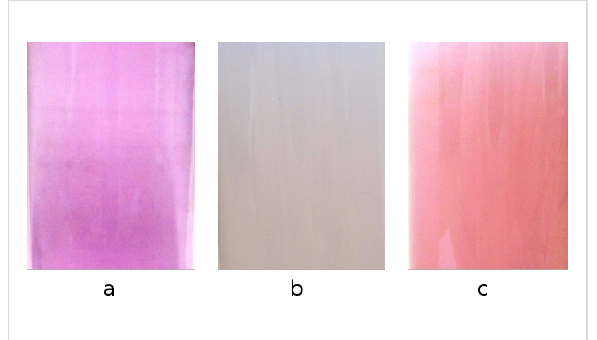
Figure 5: The color during the complexation with phenolphthalein and adamantyl carboxylate. (a) Phenolphthalein solution in water at pH > 7, (b) nanoparticles suspension added to the phenolphthalein solution, (c) nanoparticles suspension in phenolphthalein solution after the addi- tion of adamantyl carboxylate.